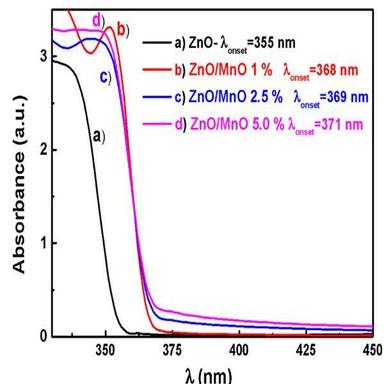
UV–vis spectra of ZnO/MnO nanocomposite; a) 0% Mn, b) 1% Mn, c) 2.5% Mn and d) 5.0% Mn.